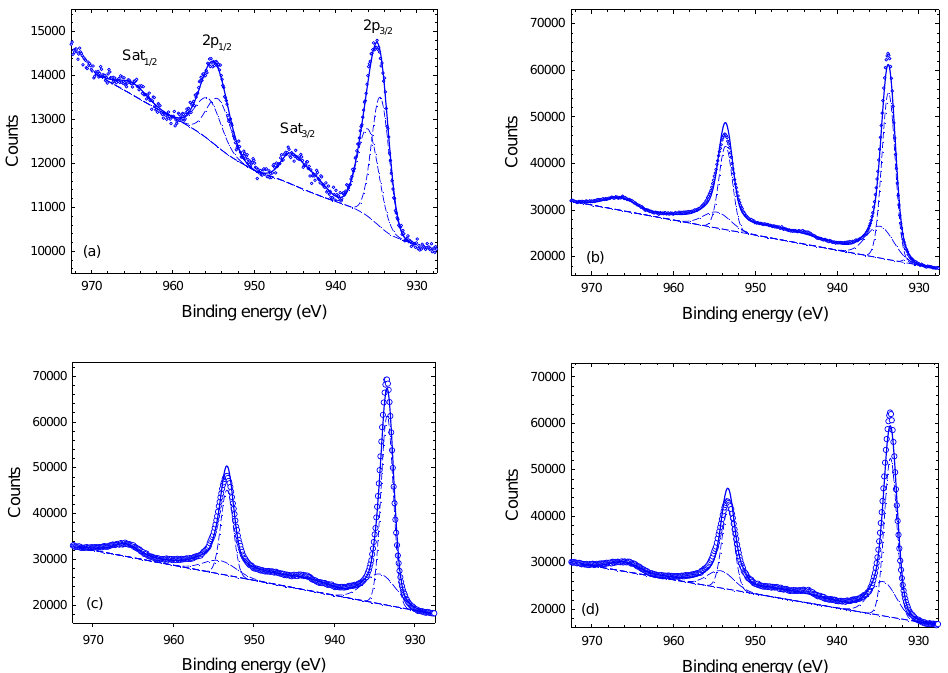
Figure 4. XPS spectra of Cu-2p core peak of Ti x -Cu y N z film at different depths; where ( a ) at surface, ( b ) 1 µ m, ( c ) 3 µ m and ( d ) 4 µ m. According to Biesinger et al., Cu-2p lines from metallic Cu(0) and Cu(I) oxide appear at 932.6 eV and 932.2 eV, respectively, while Cu(II) oxide and hydroxide contribute at 933.8